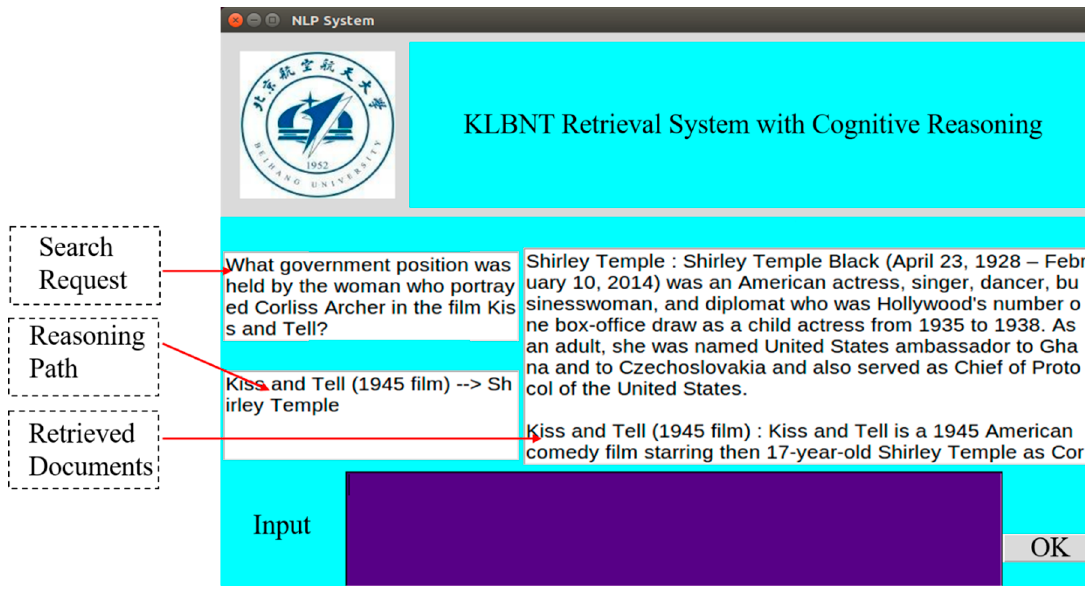
Figure 7. The KLBNT Retrieval System supported by 2RCR-IR technology.